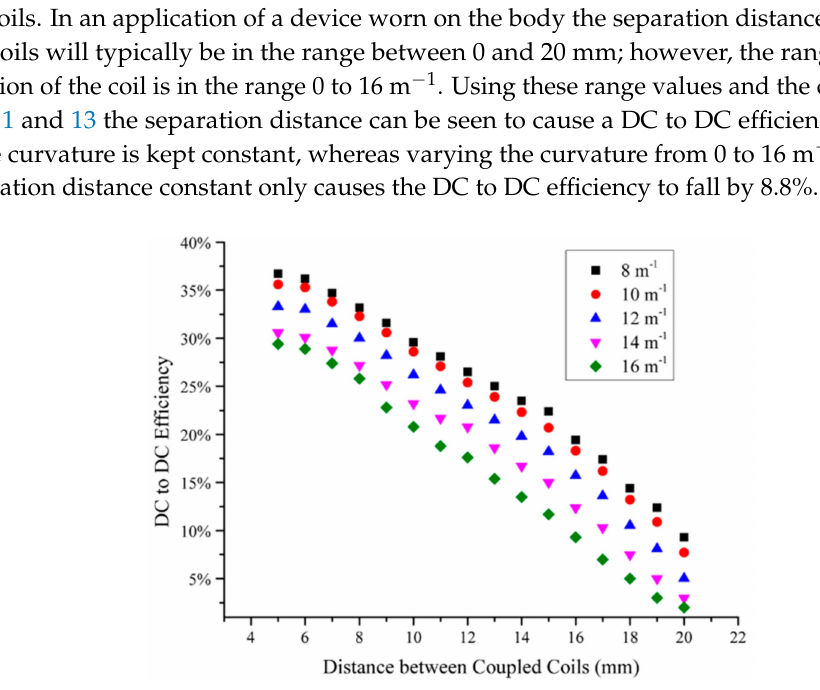
Figure 13. DC to DC efficiency of the WPT system employing a deformed receiver coil under different curvature against the separation distance from the flat transmitter